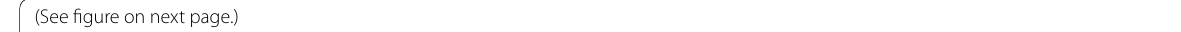
equator(See figure on next Fig. 3 Global mapping of the brightness locations of all of the orbital observations, grouped by the season: The sequence of the seasons is as follows: a Feb.–Apr. 2007, b May–Jul. 2007, c Aug.–Oct. 2007, d Nov. 2007–Jan. 2008, e Feb.–Apr. 2008, f May–Jul. 2008, and g Aug.–Oct. 2008. Single‑peaked events are shown as red circles, and double‑peaked events are shown as solid blue triangles and green squares. The dotted lines indicate the geomagnetic equator, and the solid lines at 0° latitude correspond to the geographic